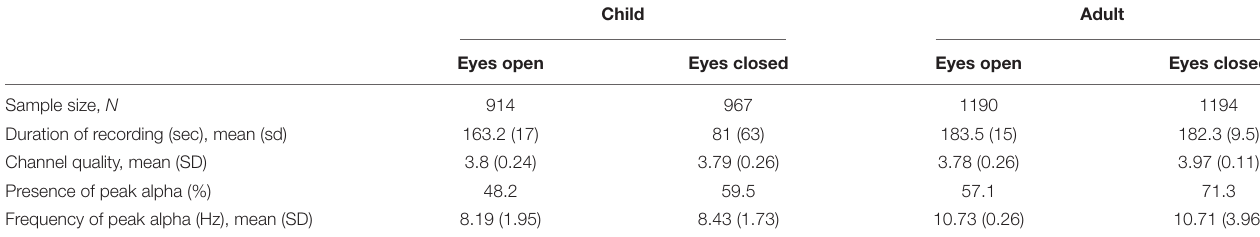
TABLE 3 | Study component